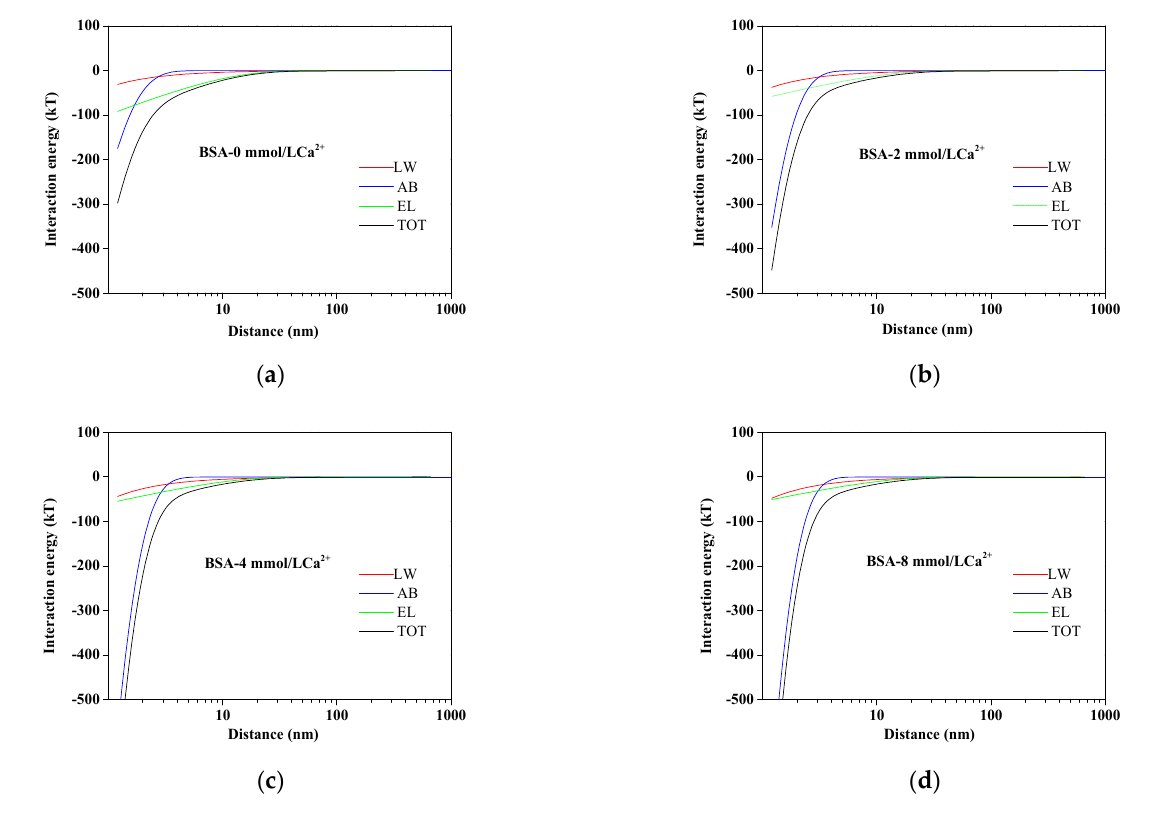
Figure 5. Variation of AEM–BSA interaction energy profiles at different calcium ion concentrations: ( a ) BSA without Ca 2+ ; ( b ) BSA with 2 mmol/L Ca 2+ ; ( c ) BSA with 4 mmol/L Ca 2+ ; ( d ) BSA with 8 mmol/L Ca 2+ .